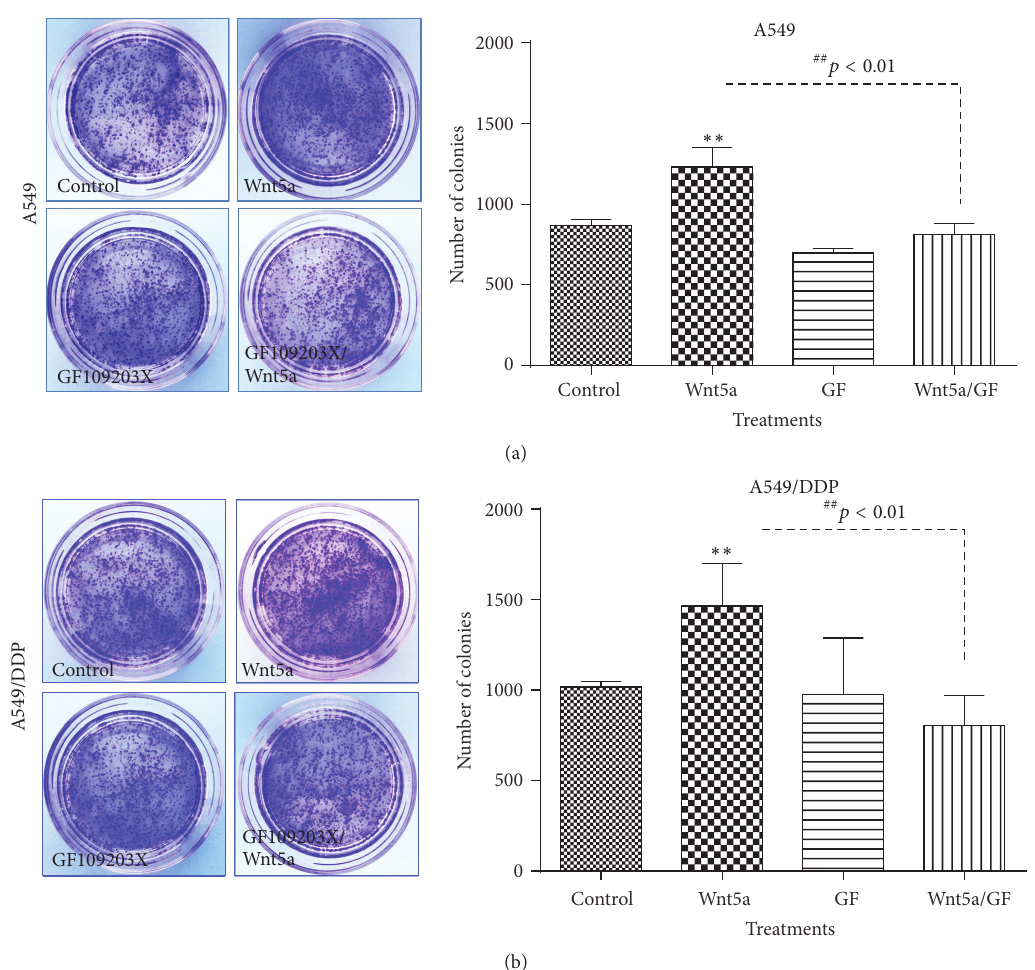
Figure 4: Wnt5a enhances the stemness of lung cancer cells determined by a clonogenic assay. A549 and A549/DDP cells were cultured with Wnt5a-CM with or without PKC inhibitor GF109203X; the capacity of clone formation was analyzed by using a clonogenic assay. (a) Representative images of clonogenic assay for A549 cells (left panel) and its relevant quantification of the total number of colonies from three 6-well plates (right panel). (b) Representative images of clonogenic assay for A549/DDP cells (left panel) and its relevant quantification of the total number of colonies from three 6-well plates (right panel). Wnt5a showed an ability to enhance clonogenic capacity in both A549 and A549/DDP cells. In contrast, GF109203X was able to inhibit the Wnt5a-enhanced clonogenicity in these cells. Compared with Control-CM group, ∗∗ represents 𝑝 < 0.01 . Data represented the mean ± SD from three independent triplicated experiments ( 𝑁 = 9 ). GF: